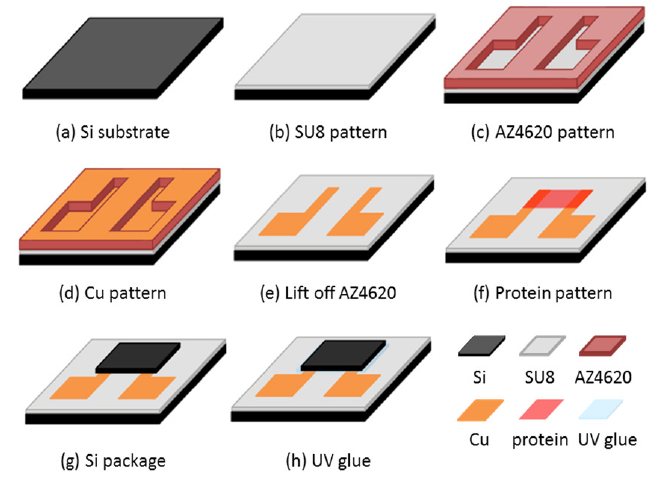
Figure 2. Schematic diagram of the test chip